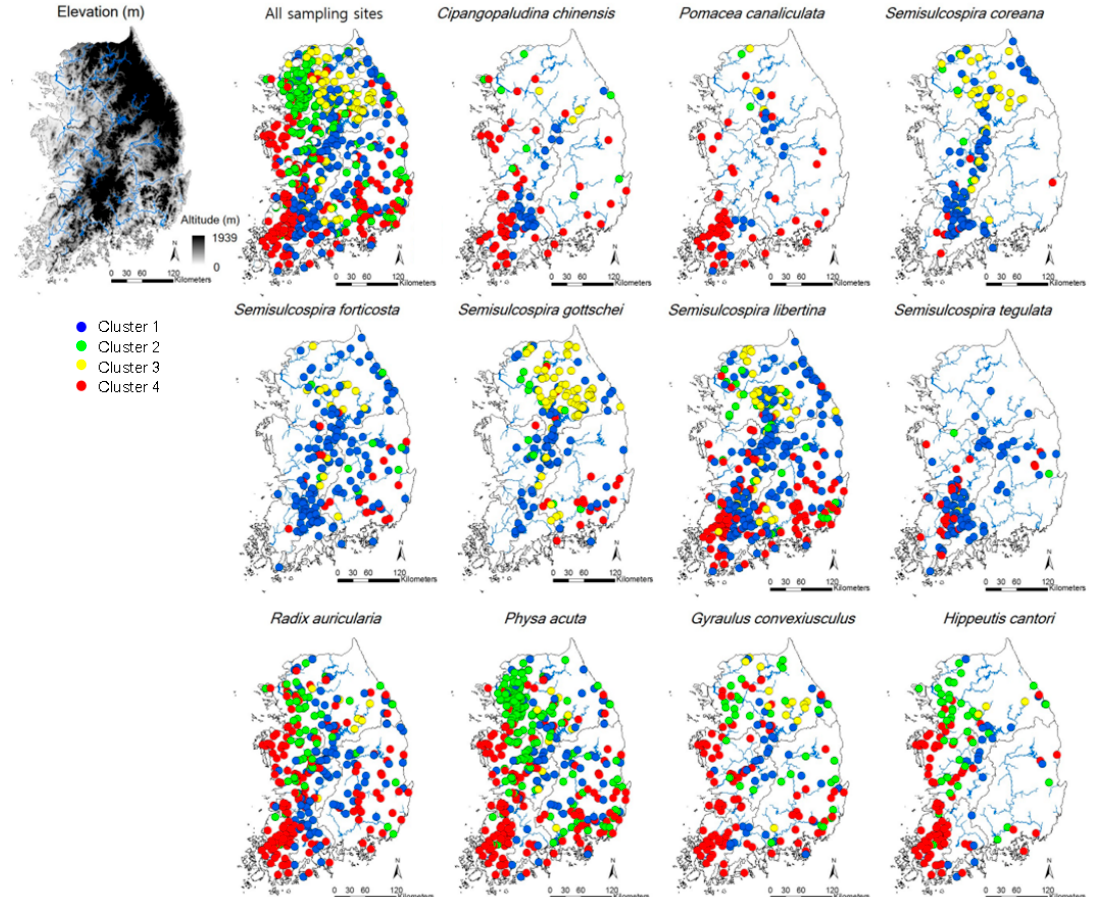
Figure 1. Sampling sites and occurrence patterns of 11 gastropod species in Korea that present more than a 10% frequency of occurrence. Classification of sampling sites were defined in Figure 2. The clusters reflected the differences of environmental condition at each sampling site.